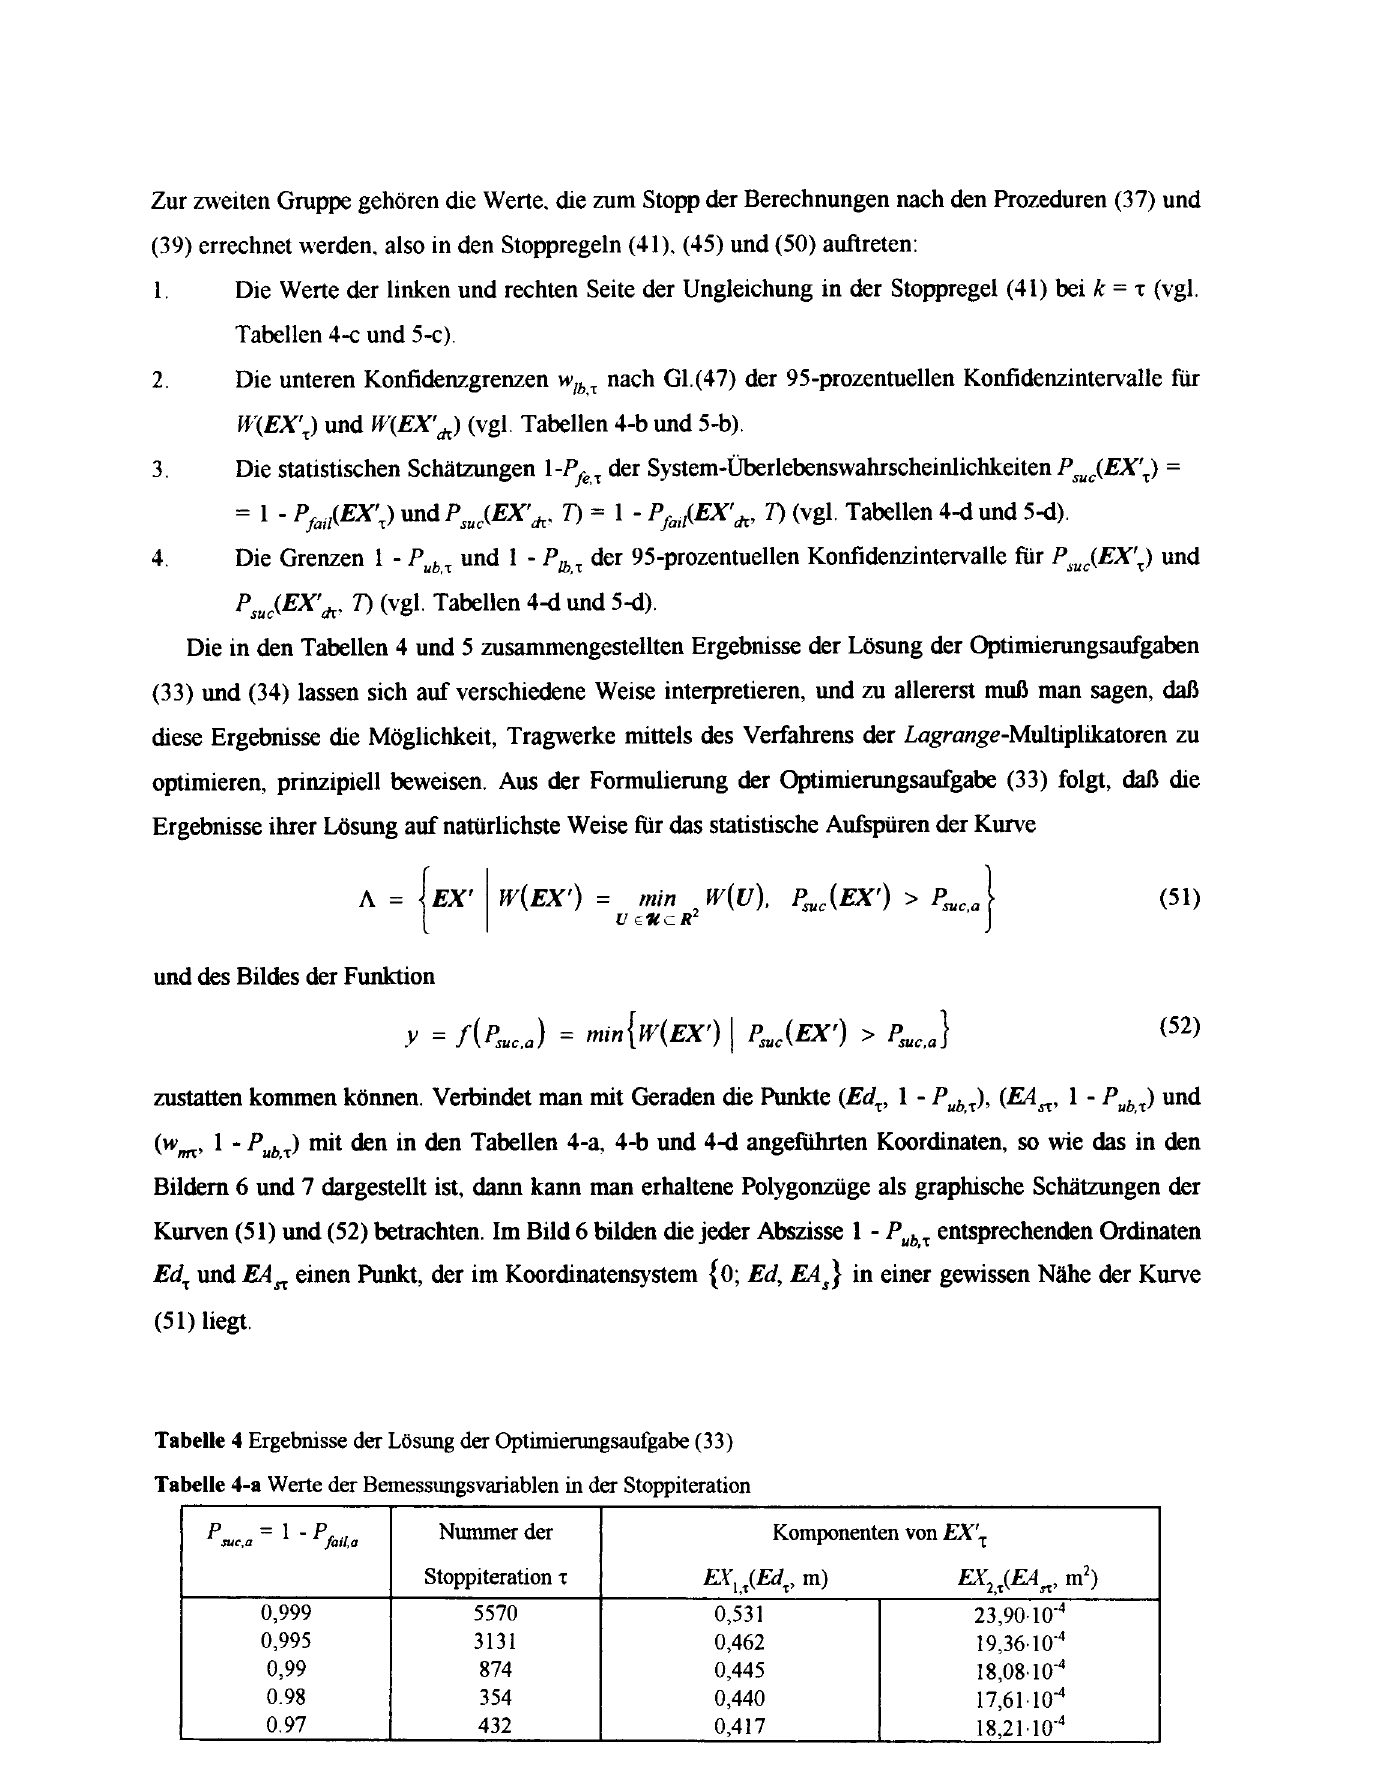
Tabelle 4 Ergebnisse der LosWig der OptimierWigsaufgabe (33) Tabelle 4-a Werte der BemessWigsvariab1en in der